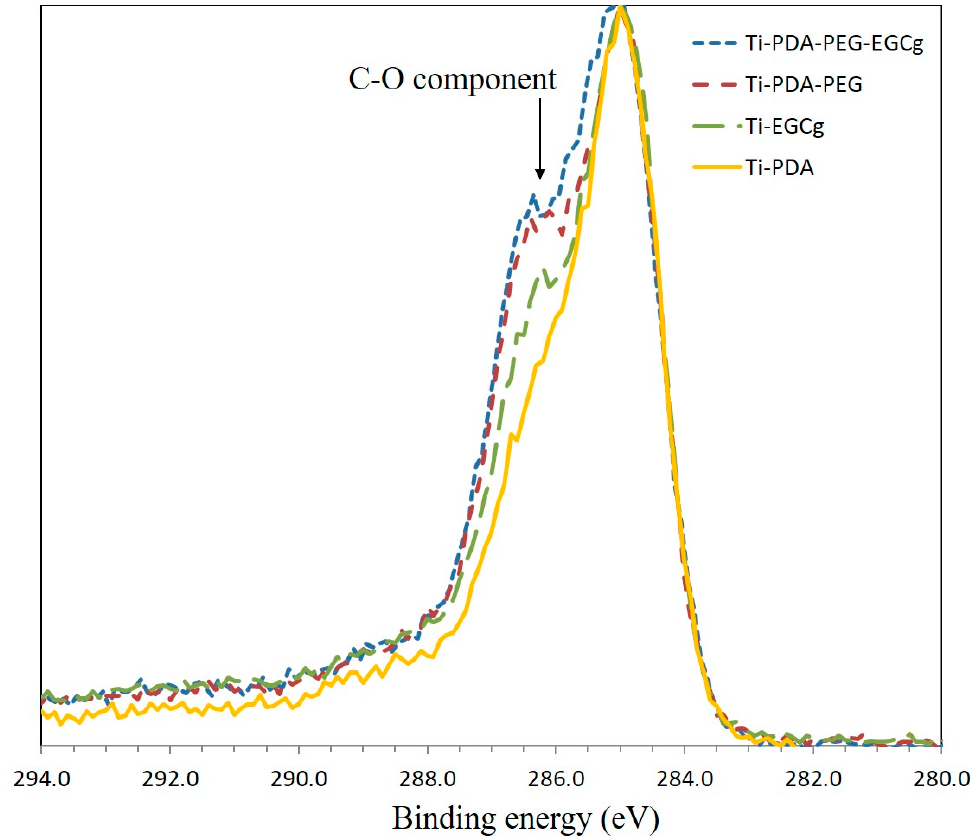
Figure 2. Normalized C1s peak of tested samples. The binding energy of all peaks has been referenced to the internal standard C-C component (285.0 eV). The figure shows the increasing contribution to the peak of the 286.5 eV component due to C-O containing moieties.